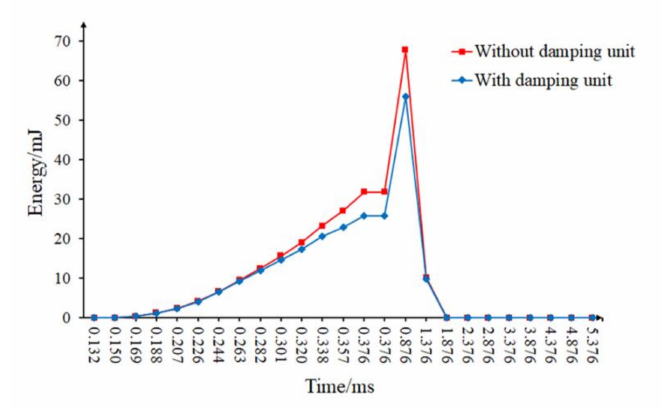
Figure 9. Internal energy change of single